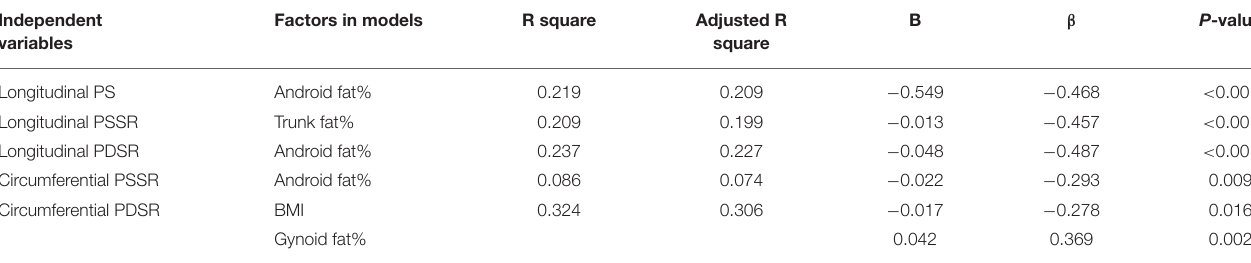
TABLE 6 | Multivariable linear regression analysis of association between regional fat distributions and RV strains in whole population. Independent variables